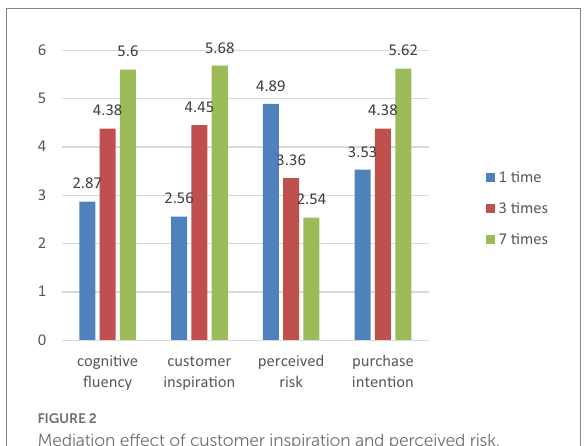
FIGURE 2 Mediation effect of customer inspiration and perceived